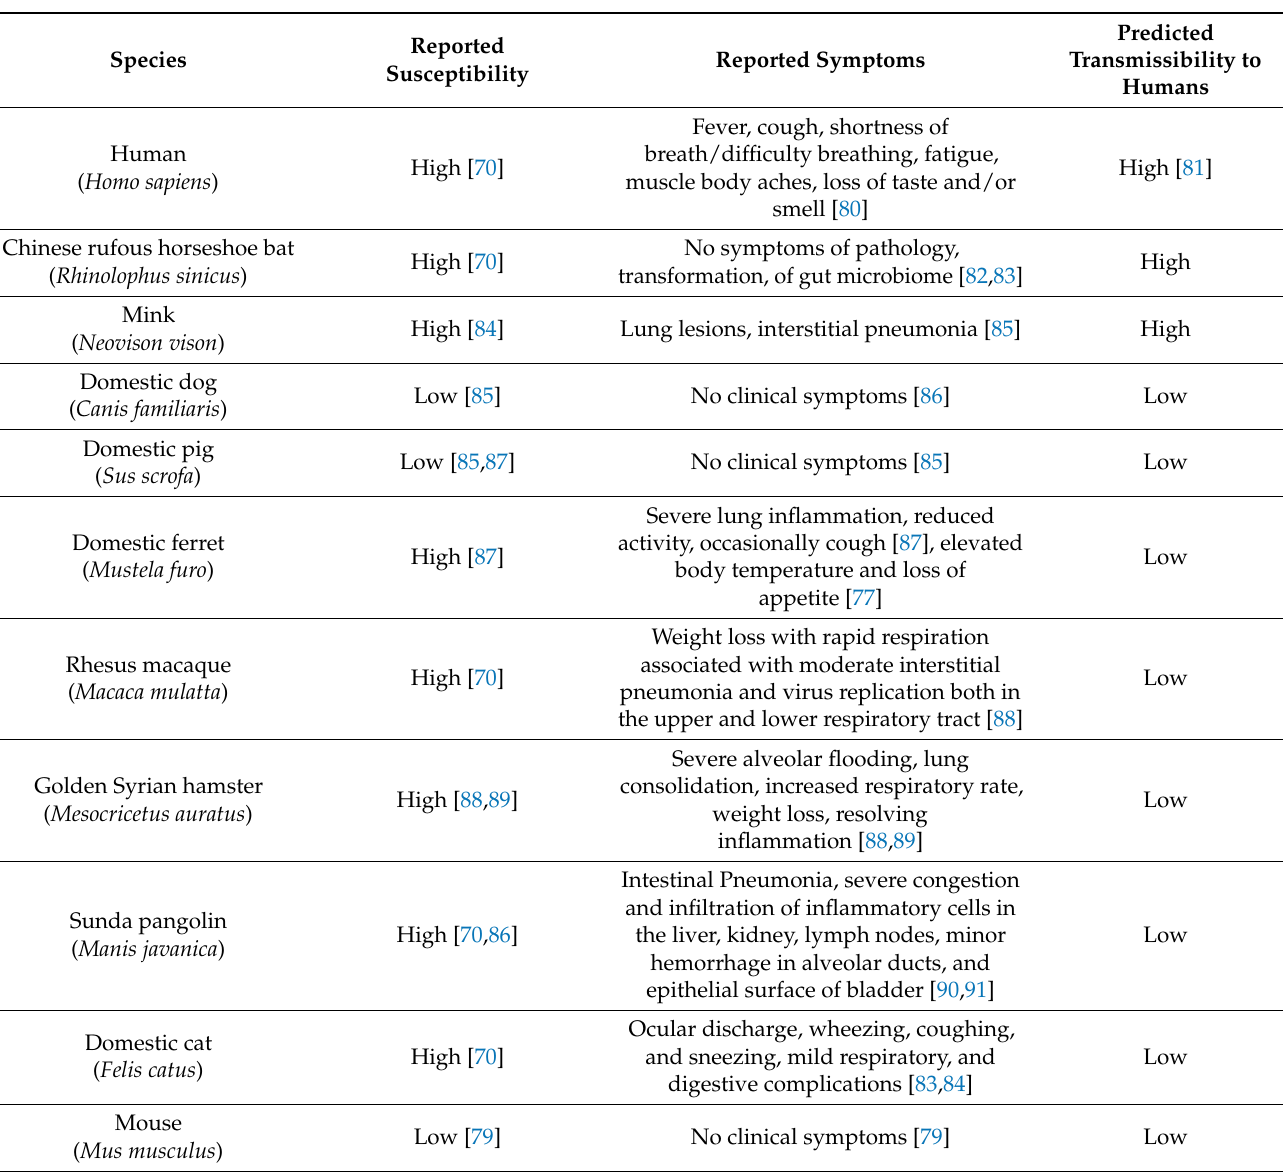
Table 2. Comparison of the reported susceptibility, reported symptom presentation, and expected transmissibility in eleven mammalian species: human ( Homo sapiens ), Chinese rufous horseshoe bat ( Rhinolophus sinicus ), mink ( Neovison vison ), domestic dog ( Canis familiaris ), domestic pig ( Sus scrofa ), domestic ferret ( Mustela furo ), rhesus macaque ( Macaca mulatta), golden Syrian hamsters ( Mesocricetus auratus ), Sunda pangolin ( Manis javanica ), domestic cat ( Felis catus ), and mouse ( Mus musculus ). Predicted transmissibility is based on reported susceptibility and reported